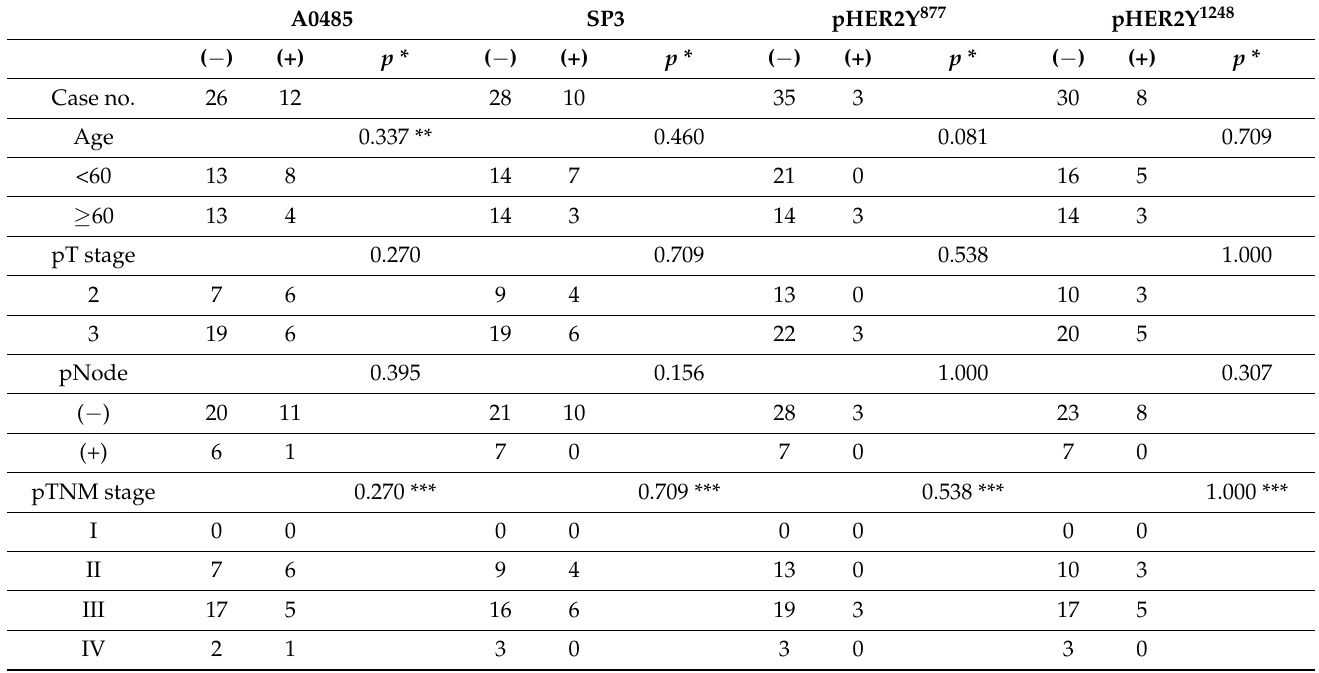
Table 1. Clinicopathological characteristics associated with positivity in the four HER2 assays.